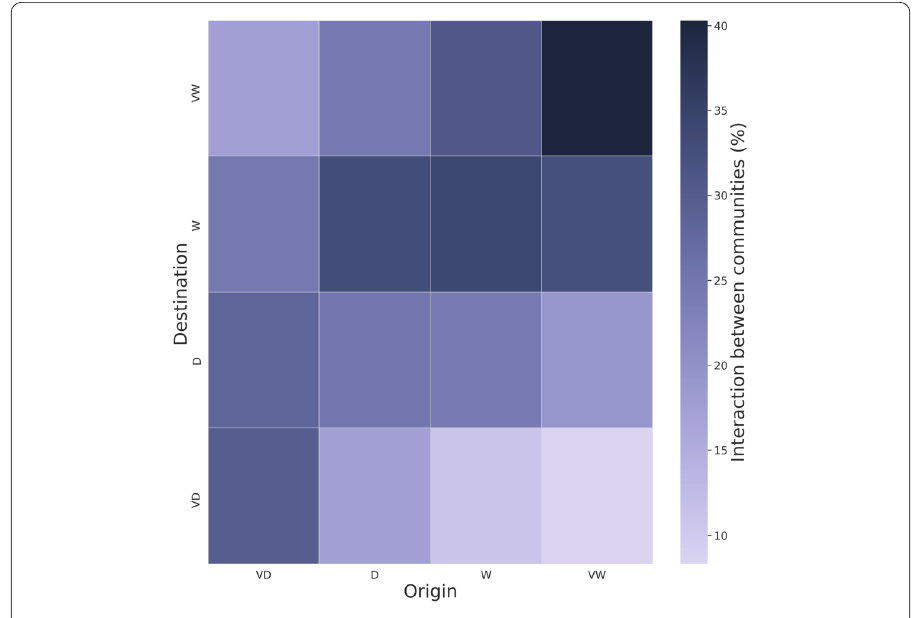
Figure 8 Interaction ratio between communities